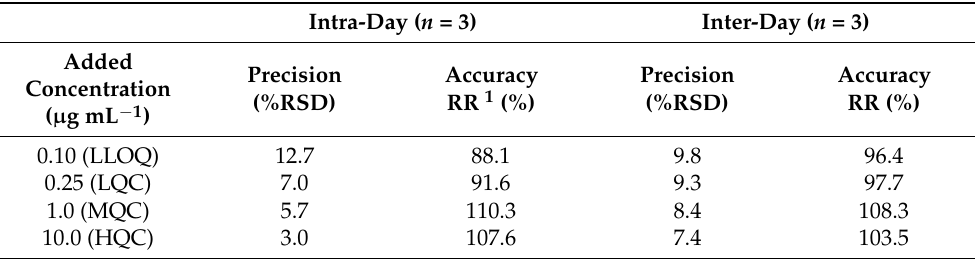
Table 1. Intra-day and inter-day precision and accuracy data of the FPSE-HPLC-UV method for the quantitation of AMTB in human